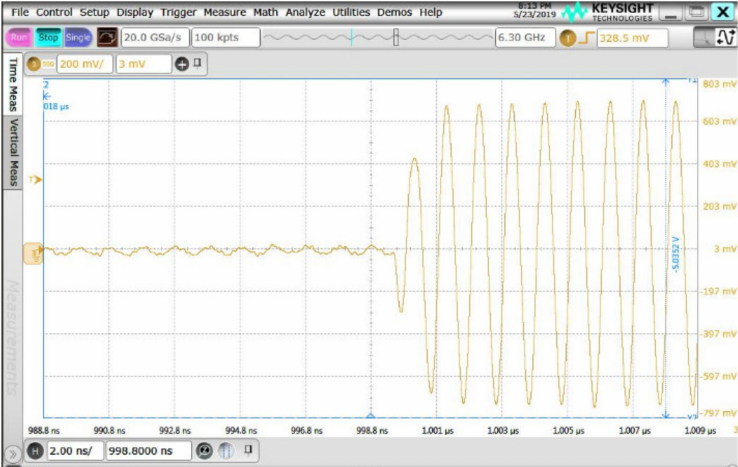
Figure 16. The rising edge of the switch during transition from OFF state to ON state.